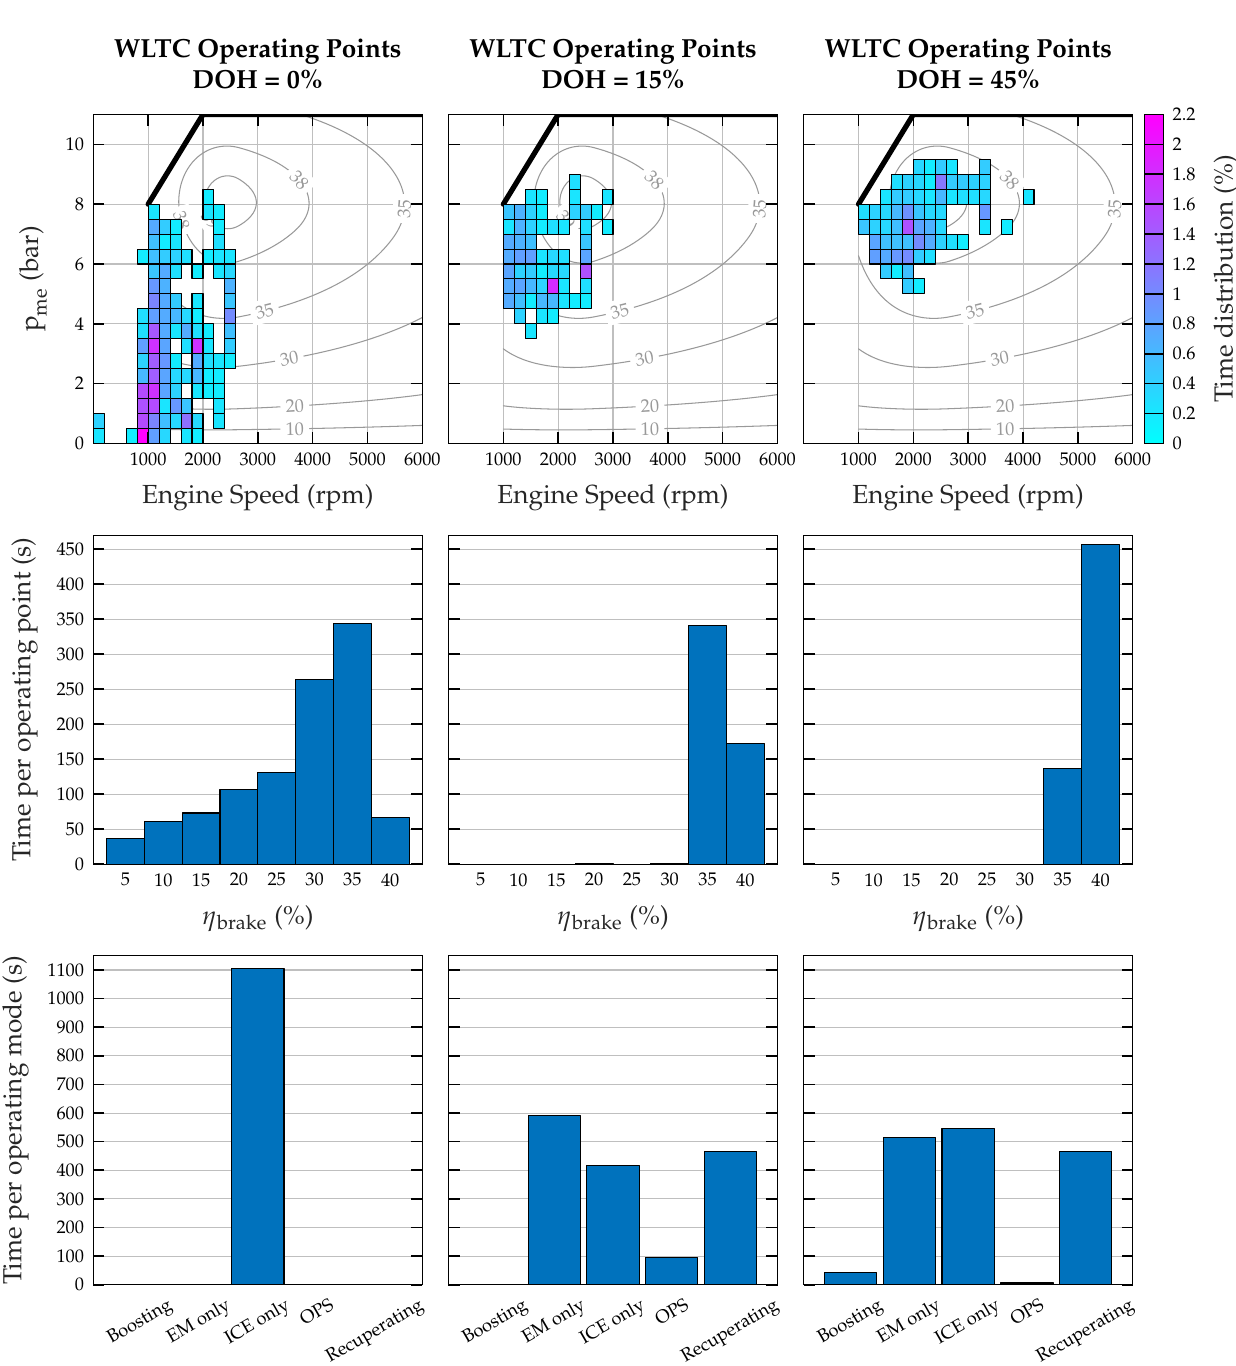
Figure 9. Visualization of the camshaft-equipped NA ICE operation for HEVs with a DOH of 0%, 15%, and 45%, respectively. The top row shows the engine maps with time distribution of the operation points. The middle and bottom rows show histograms with the time spent at a specific brake efficiency range and operating mode, respectively.